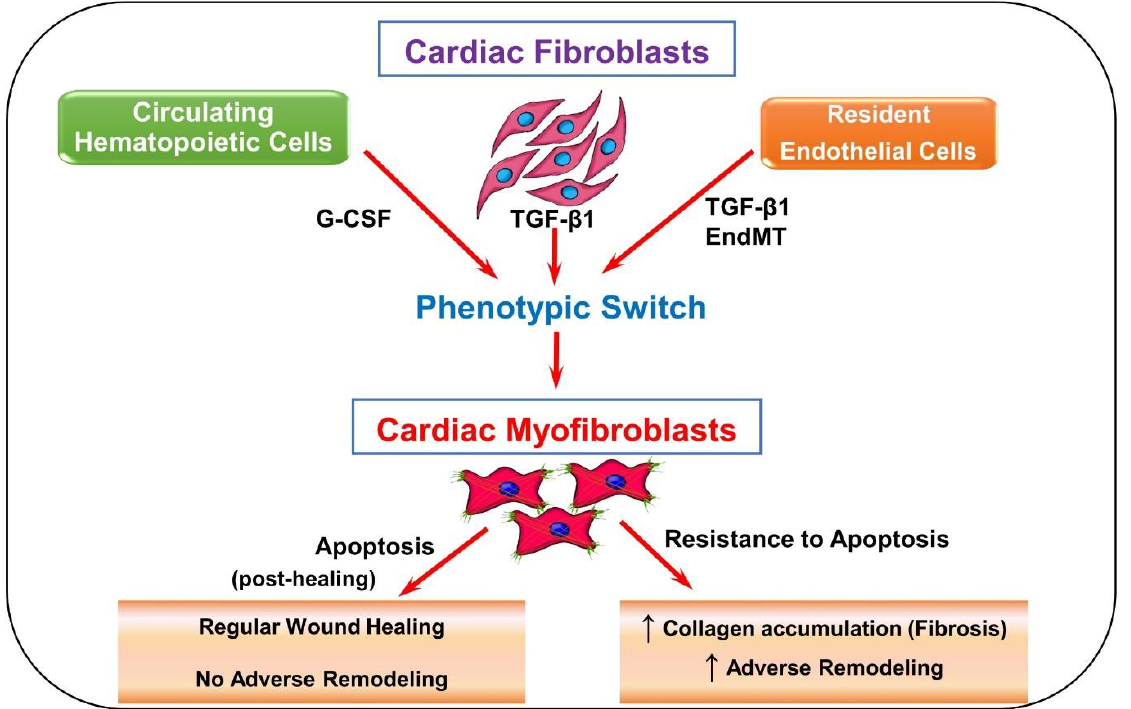
Figure 1. Schematic depicting fibroblast to myofibroblast differentiation. Transforming growth factor-beta 1 (TGF- β 1) is the most common pathway involved in the differentiation of fibroblasts into myofibroblasts. Resident fibroblasts, endothelial cells, and circulating hematopoietic cells may have the ability to become myofibroblasts via TGF- β 1-induced pathways, granulocyte colony-stimulating factor (G-CSF), and endothelial-to-mesenchymal transition (EndMT). Progenitor stem cells and pericytes are also speculated to contribute to the myofibroblast population. Once myofibroblasts are differentiated, they produce more collagen and various pro remodeling factors required for healing. The expression of these factors at the site of injury promotes repair and remodeling of the injured myocardium. Usually after repair, myofibroblasts undergo apoptosis, decreasing the amount of collagen and pro remodeling factors expressed. When myofibroblasts fail to undergo apoptosis, more collagen and pro remodeling factors are expressed.